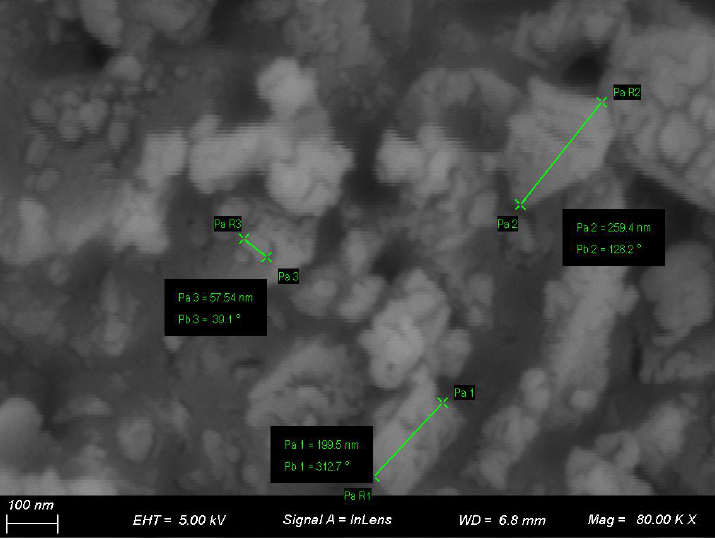
Figure 4. Scanning electron microscope image of nanodiamond powder (80,000×).